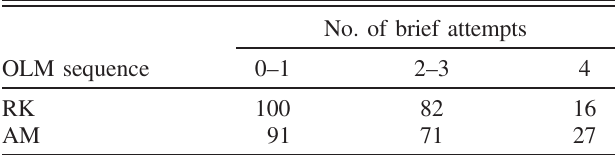
TABLE I. The number of students in each OLM sequence by their number of brief attempts. The brief attempt groups consist of those who had 0 – 1, 2 – 3, or 4 brief attempts throughout the first four